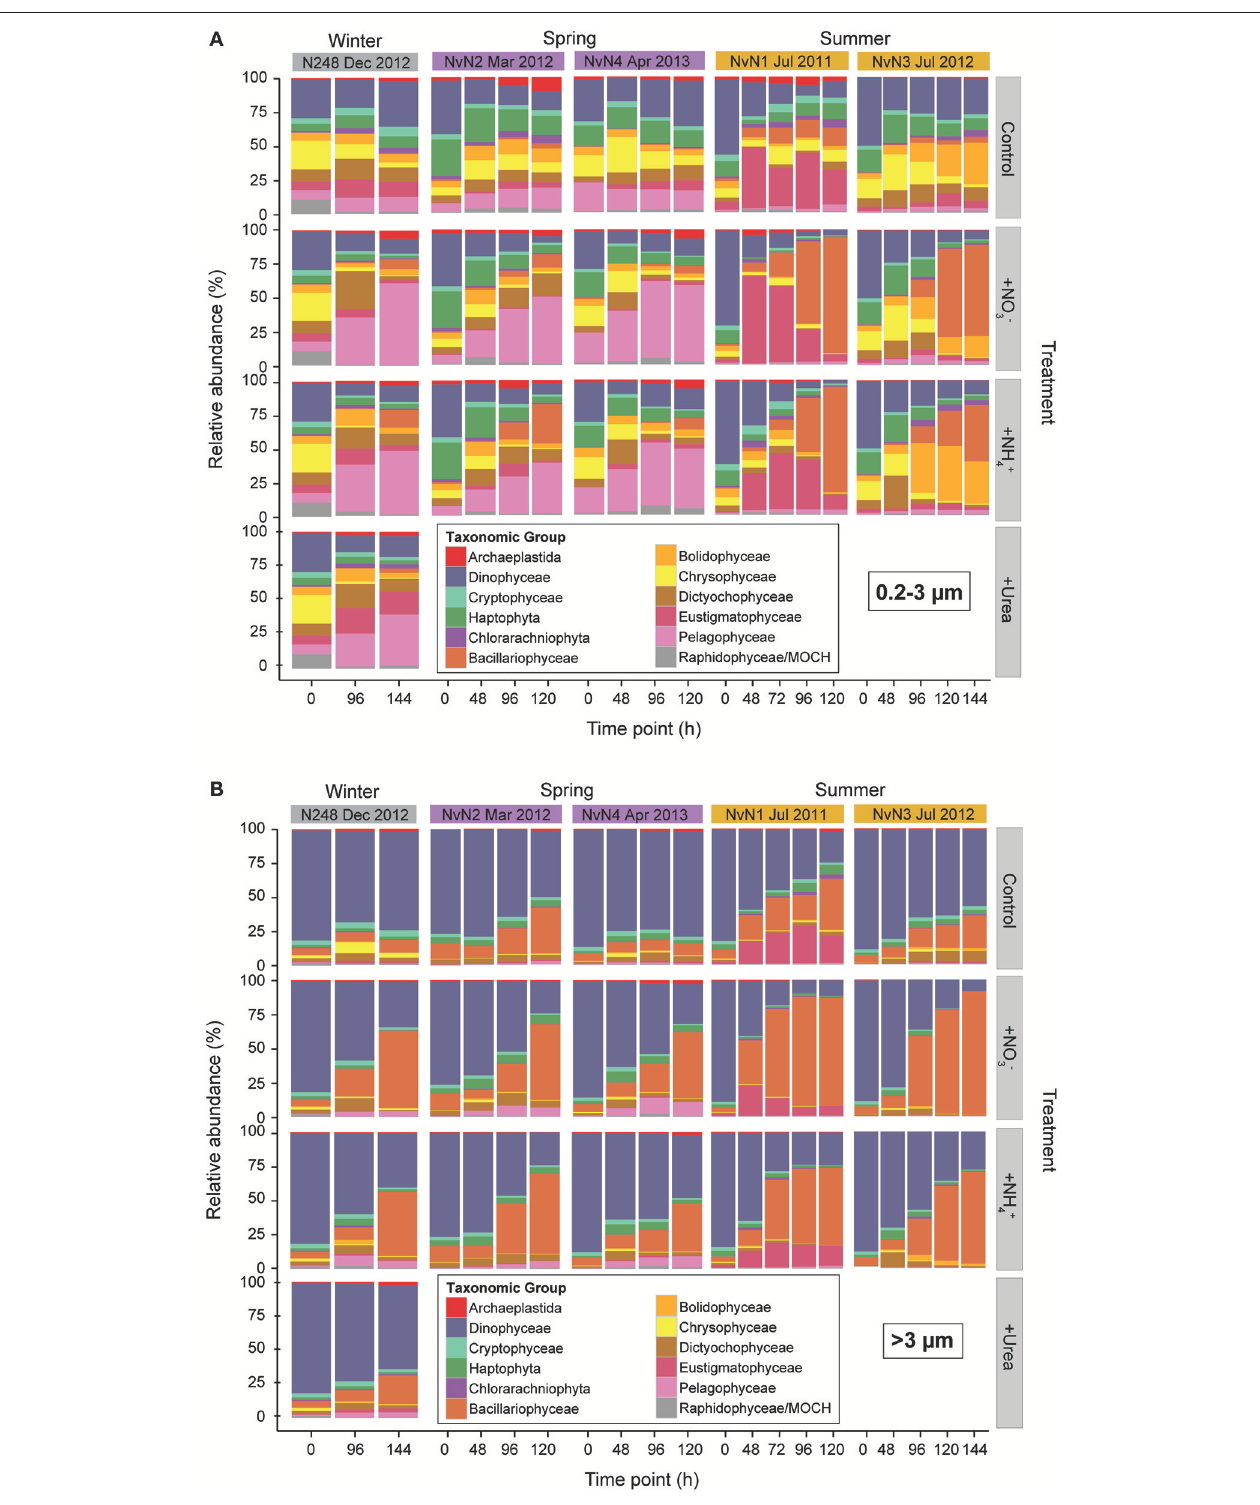
FIGURE 4 | Relative abundances (%) of (A) picophytoplankton and (B) > 3 µ m phytoplankton taxa, binned by time point sampled per experiment conducted in different seasons. Columns indicate treatment mean (of triplicate carboys) relative abundances for different experiments and rows specify the different treatments: Control, + NO − 3 , + NH + 4 , and + Urea. Colors indicate various phytoplankton taxa.